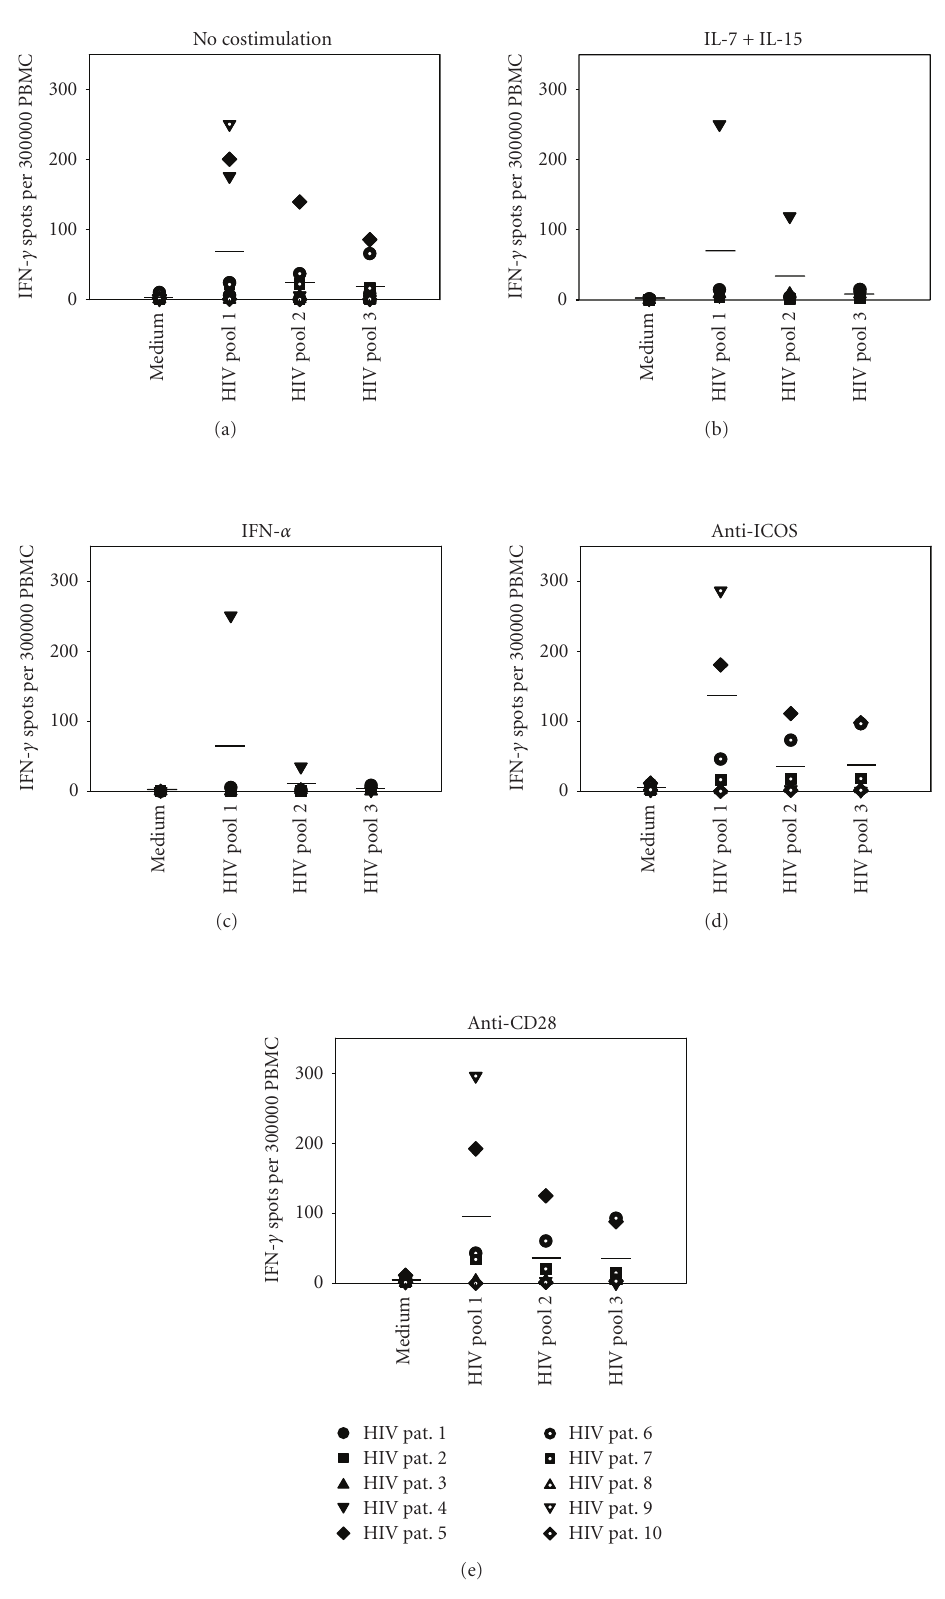
Figure 2: In vitro costimulation has no e ff ect on antigen-specific T cell responses in HIV-infected patients. PBMCs of 10 HIV-infected patients were tested in IFN- γ ELISPOT assays for their recall responses to HIV peptide pools 1, 2, and 3 (as described in Section 2) in the absence (a) or presence of IL-7/IL-15 (b), IFN- α (c), anti-ICOS (d), or CD28 (e). For each individual, the mean spot count of duplicate wells is shown. Horizontal bars indicate the means of all individual responses to the respective antigens. Symbols in (a) also apply to